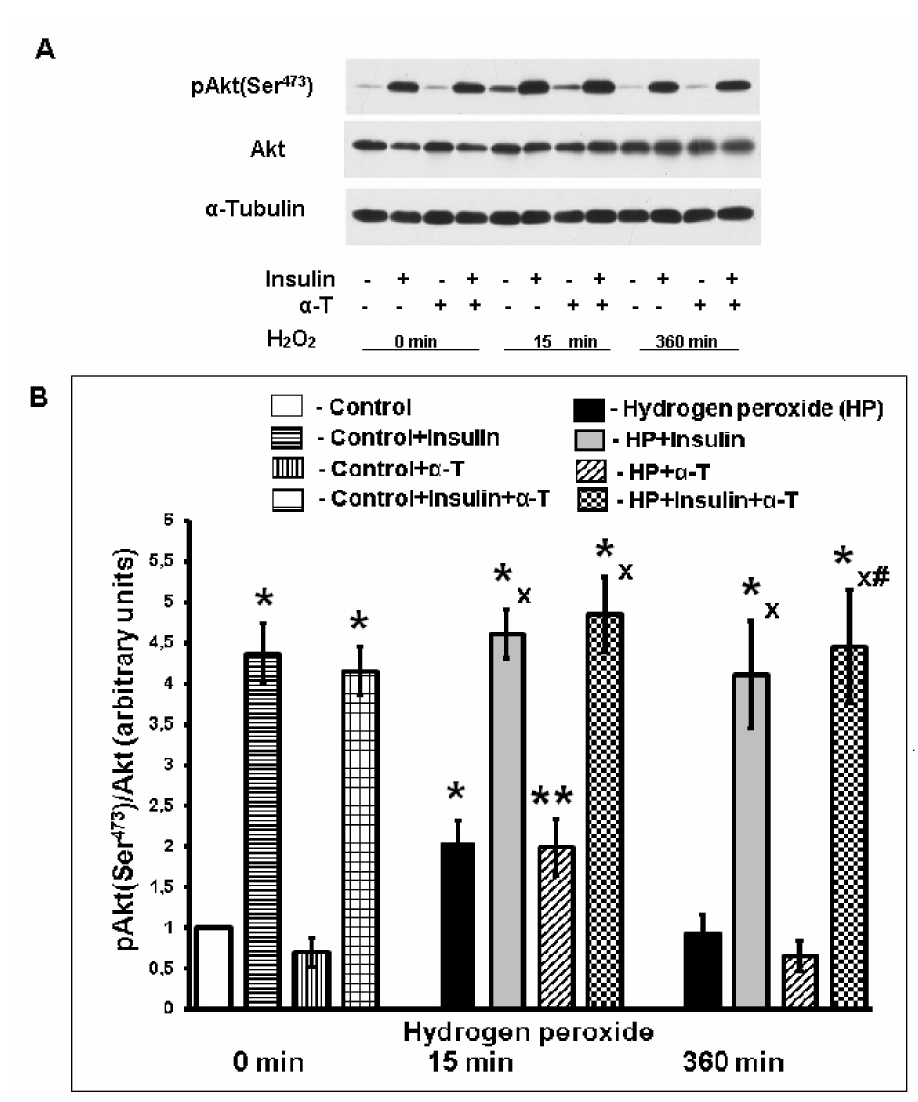
Figure 4. The effect of hydrogen peroxide, insulin and α -T on the activity of Akt (pAkt (Ser 473 )/Akt) in brain cortical neurons. ( A ) immunoblots of pAkt (Ser 473 ) and total Akt are shown; ( B ) the data of 6 experiments are presented as the means ± SEM. The brain cortical neurons were pre-incubated for 1 h with 1 µ M insulin or for 18 h with 50 µ M α -T or with both drugs or without them. Then the neurons were exposed to 100 µ M hydrogen peroxide for 0, 15 and 360 min. The differences are significant according to Student’s paired t -test as compared: * and **—to the control, * p < 0.02, ** p < 0.05; x—to the effect of hydrogen peroxide alone, p < 0.01, #—to the effect of insulin or α -T alone, p <